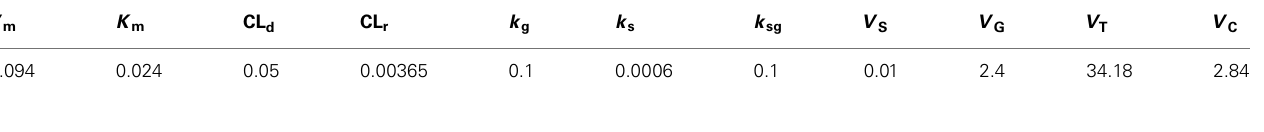
Table 1 |Average patient kinetic parameters of the average